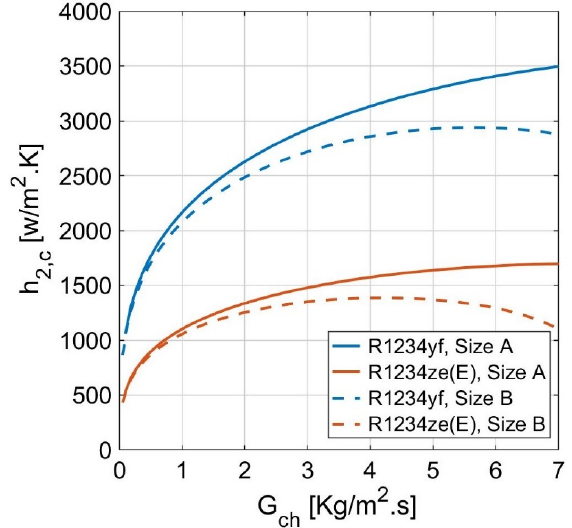
Figure 14. Cold stream two-phase convection coefficient at various cold channel mass fluxes and different plate sizes. different plate